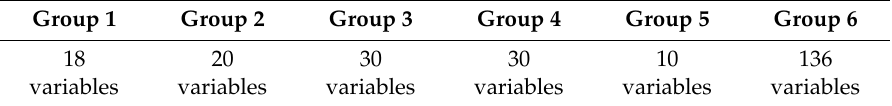
Table 3. Number of variables in each regressor group.